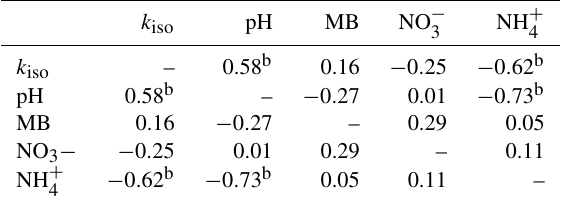
Table 1. Spearman’s rank correlation coefficients ( ρ ) for relation- ships between site mean oxygen isotope exchange rate ( k iso ), soil pH, microbial biomass (MB), exchangeable NO − able NH + measured in untreated soils ( n = 4